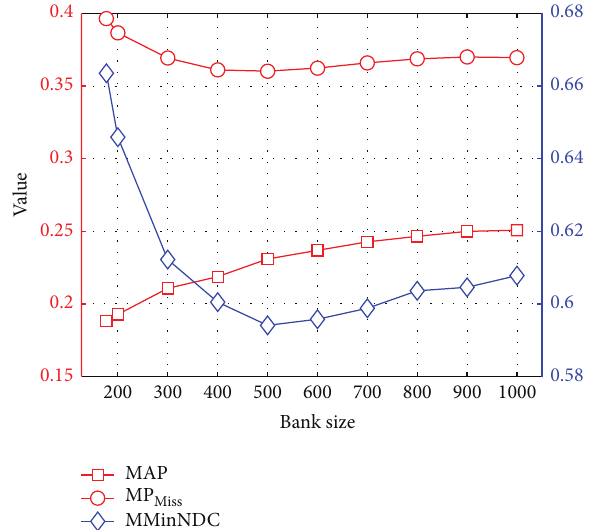
Figure 8: Event classification performance with respect to the bank